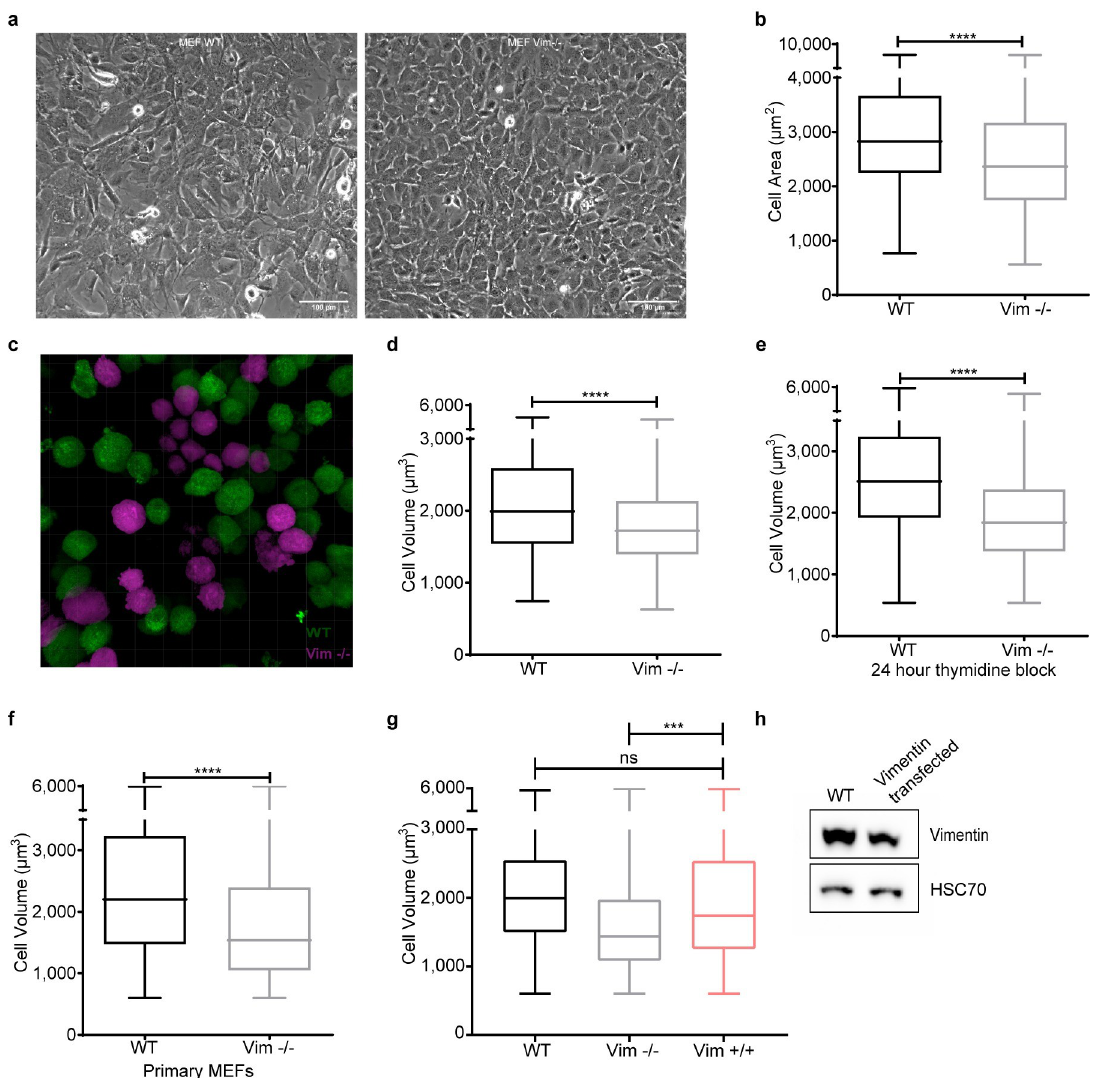
Fig 2. Loss of vimentin reduces cell size. ( a ) Phase contrast representative images of WT and Vim − / − MEFs (scale bar = 100 μ m). ( b ) Distribution of the cell area obtained from phase contrast images measured using Fiji ( n = 3). ( c ) Micrograph of WT (green) and Vim − / − (magenta) MEFs image made with Imaris software for cell volume analysis. ( d ) Cell volume distribution of WT and Vim − / − MEFs obtained from z-stacks from cells in suspension stained with CellTracker ( n = 3). ( e ) Cell volume distribution of WT and Vim − / − cells treated with 1 mM of thymidine for 24 hours ( n = 3). ( f ) Cell volume distribution of primary MEFs isolated from WT and Vim − / − mice ( n = 3). ( g ) Cell volume distribution of WT, Vim − / − , and pCMV script-vimentin transfected (48 hours post transfection) in Vim − / − MEFs ( n = 3). ( h ) Western blot analysis of WT and Vim − / − MEFs transfected with wild-type vimentin. ��� p < 0.001, ���� p < 0.0001. The data underlying the graphs shown in Fig 2B and 2D–2G can be found in S1